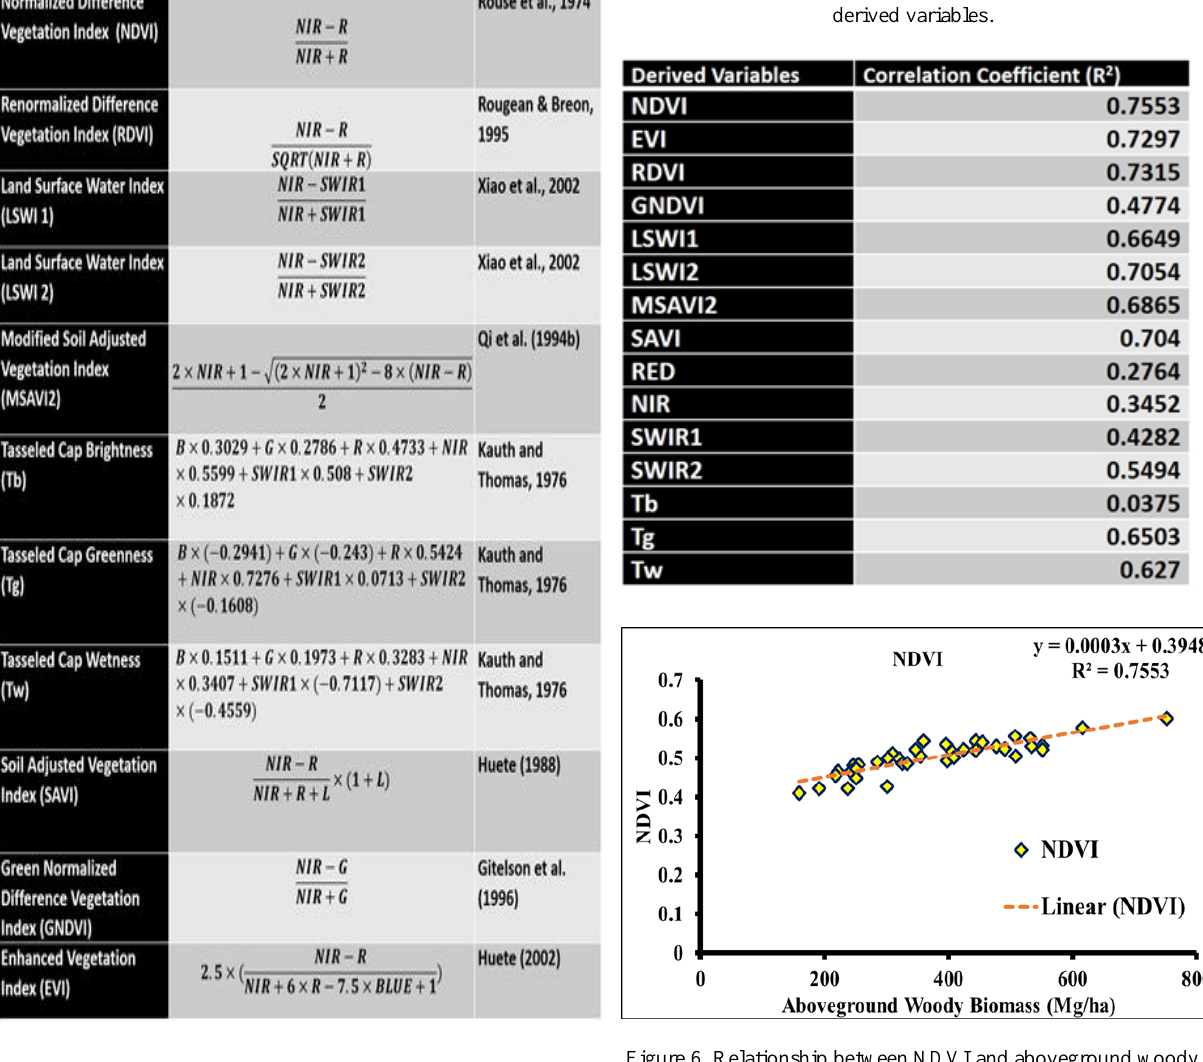
Figure 6. Relationship between NDVI and aboveground woody biomass based on correlation coefficient (R 2